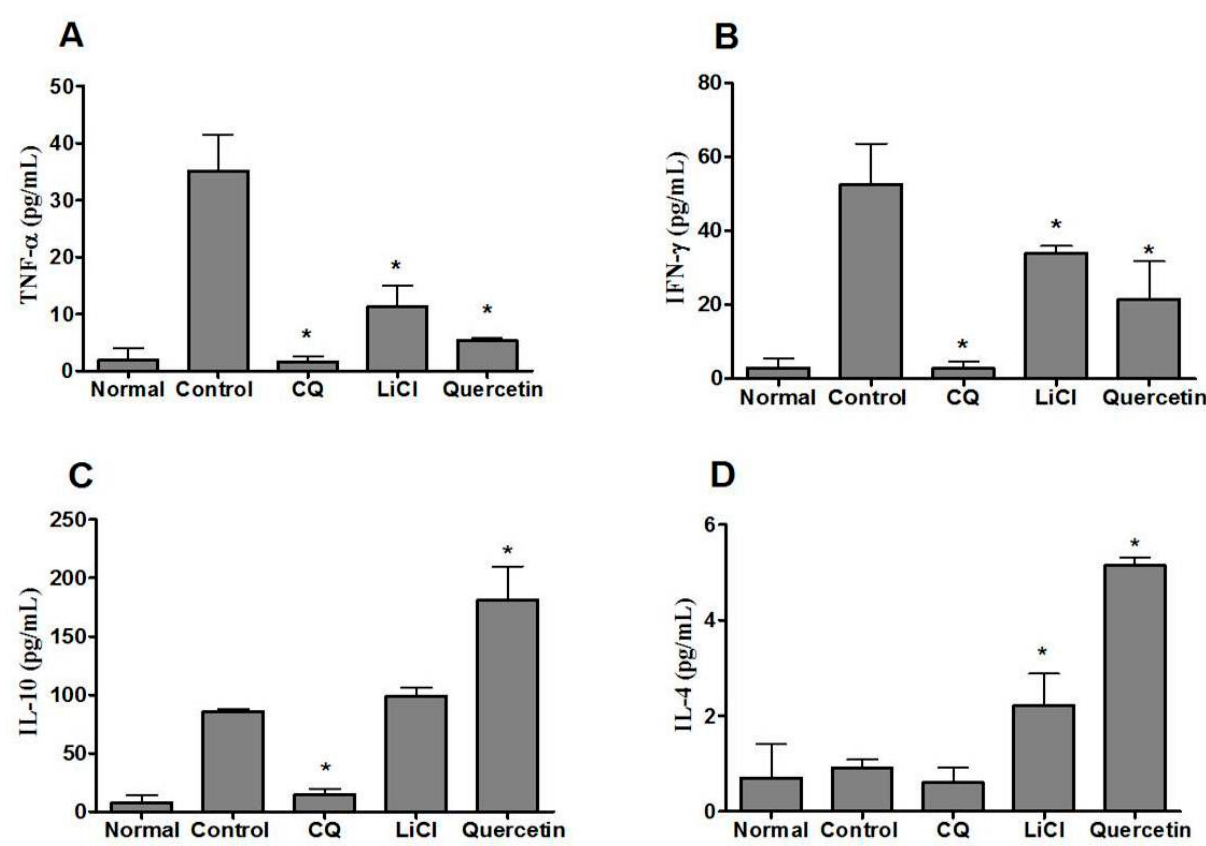
Figure 4. At day 4, post-infection of P. berghei NK65, pro-inflammatory cytokine ( A ) TNF- α , ( B ) IFN- γ and anti-inflammatory cytokines ( C ) IL-10 and ( D ) IL-4 levels in serum of mice administered with CQ, LiCl, or quercetin. Data represent mean ± SD of normal (non-infected), control (infected), and CQ/LiCl/quercetin-treated infected mice ( n = 7). Significant differences between control (infected) and treatment groups were determined at p < 0.05 (*).